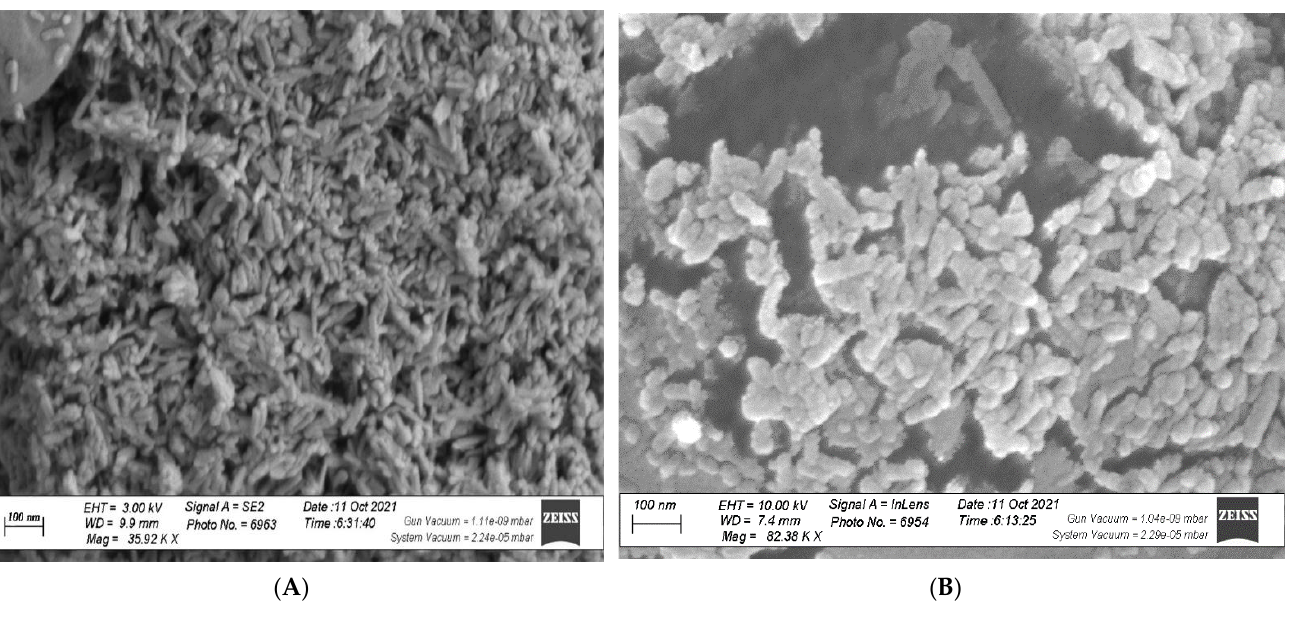
Figure 2. TEM image of zinc oxide nanoparticles (ZnONPs). ( A ) (25 nm), ( B ) (50